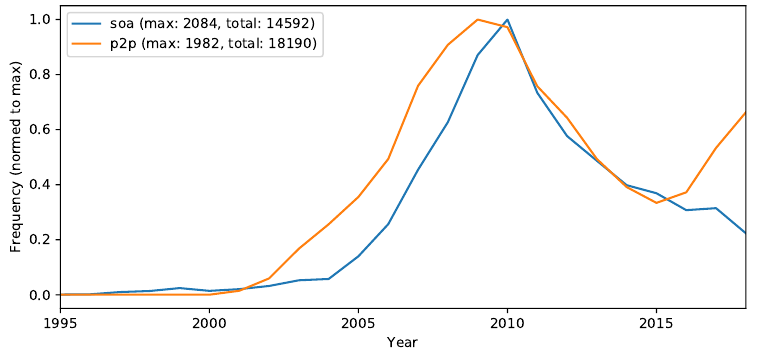
Figure 12. Trends of papers dealing with SOA, and P2P (including blockchain). Retrieved from Scopus (limited to computer science), 2018